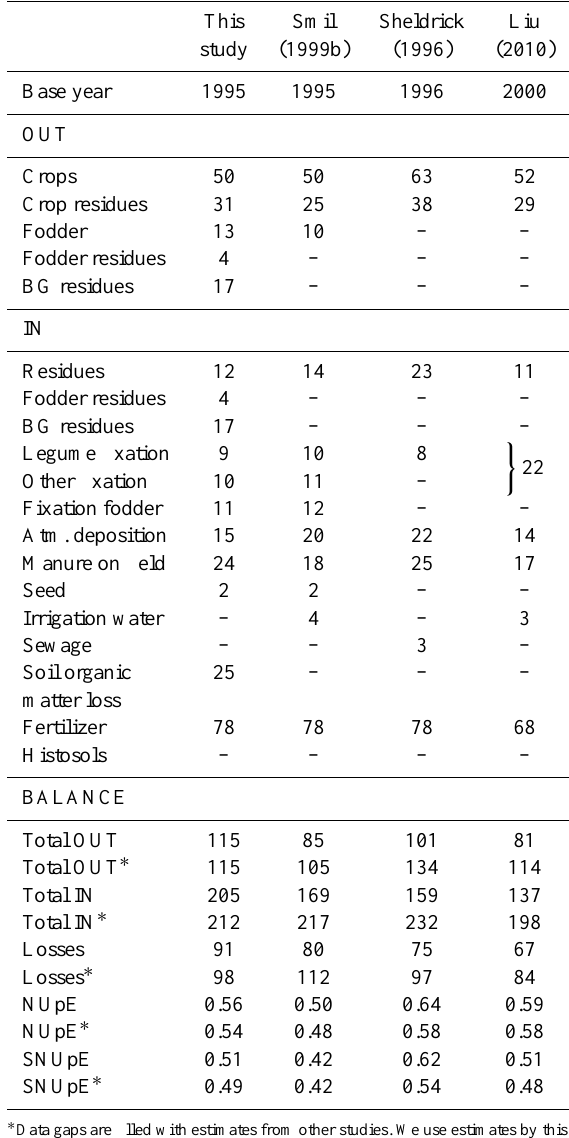
Table 3. Comparison of global cropland soil